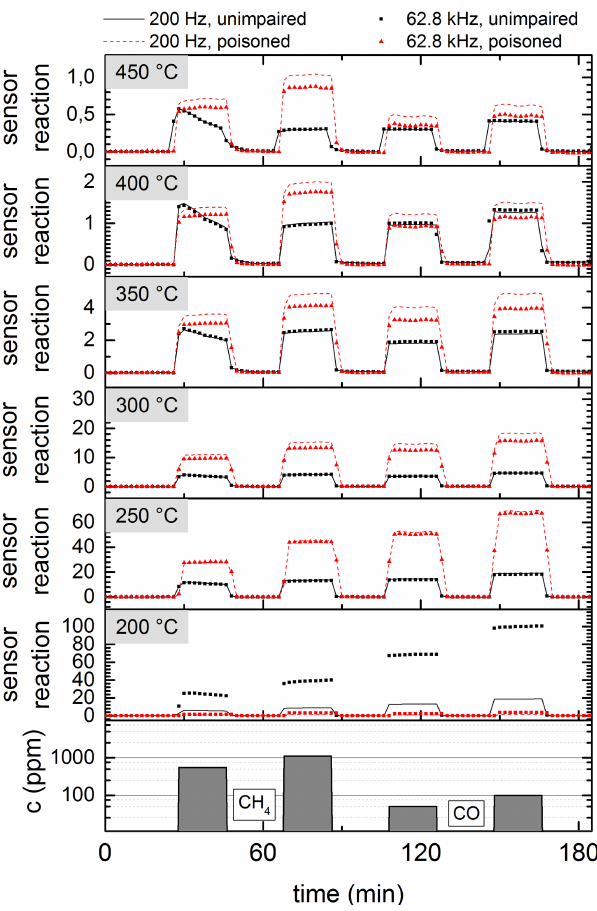
Figure 5. Laboratory measurement, carried out with commercial impedance analyzer Agilent 4294A. The graphs show sensor reac- tions for each step of the temperature cycle at 200Hz and 62.8kHz with the unimpaired as well as with the poisoned